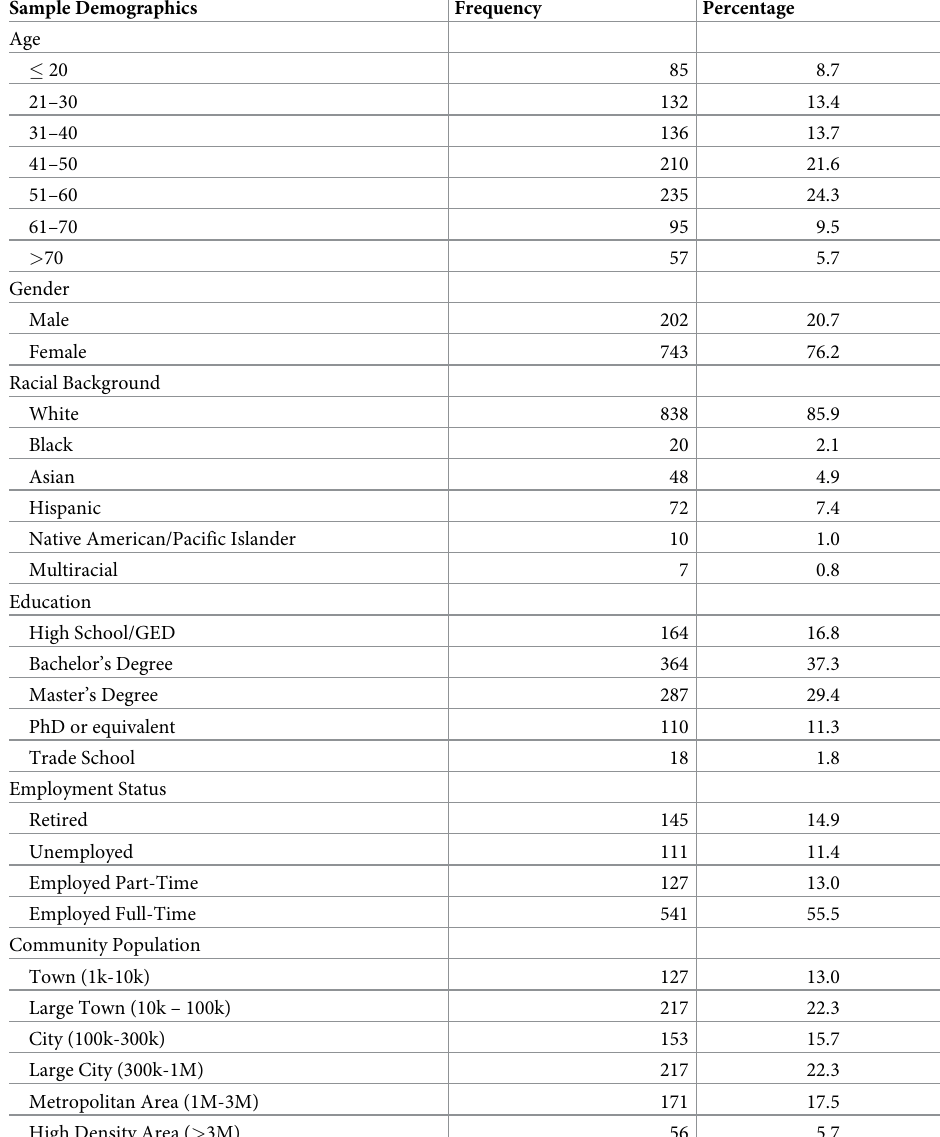
Table 1. Characteristics of participants in the sample (N =